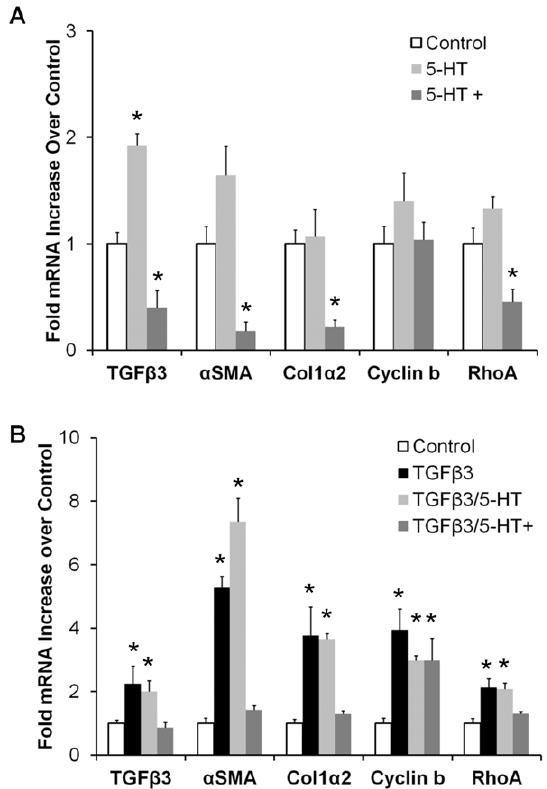
Figure 5. 5-HT treatment modulates TGF b 3 mediated gene expression. A ) TGF b 3 mRNA transcripts increase with physiological 5- HT (470 nM, 5-HT ), but decrease at high dose (47 m M, 5-HT + ). a SMA, RhoA, and col1 a 2, were not affected by physiological 5-HT dose, but were significantly downregulated with high 5-HT treatment. B ) High 5- HT treatment mitigates exogenous TGF b 3 induced contractile gene expression, while TGF b 3 induced proliferation was independent of 5-HT dose. mean 6 SEM, n=3–5 pooled samples of 8–10 cushions, *p ,